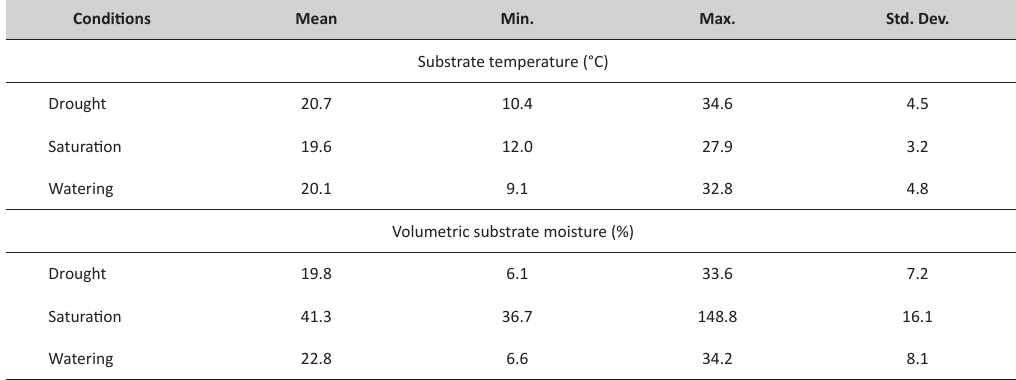
tAbLe 5. Descriptive statistics of substrate temperature (°C) and volumetric substrate